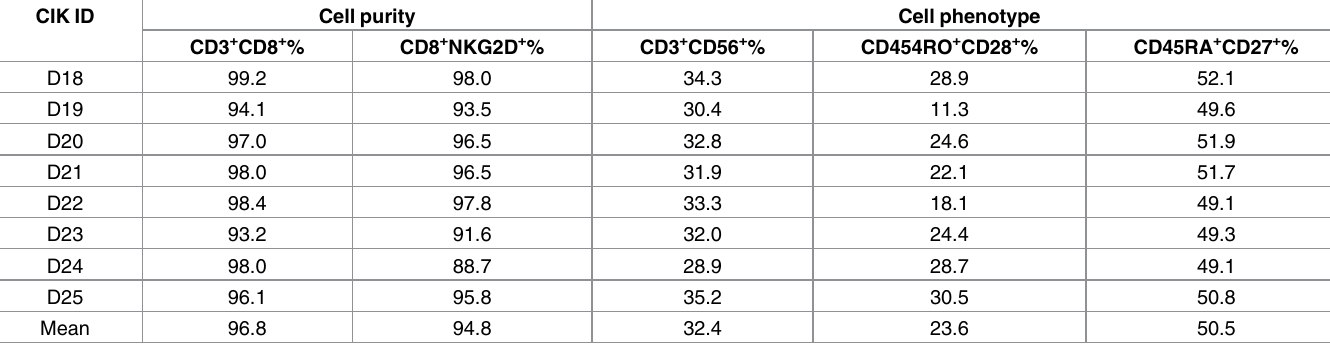
Table 3. The phenotypes of 8 cases of CD8 + CIK cell after